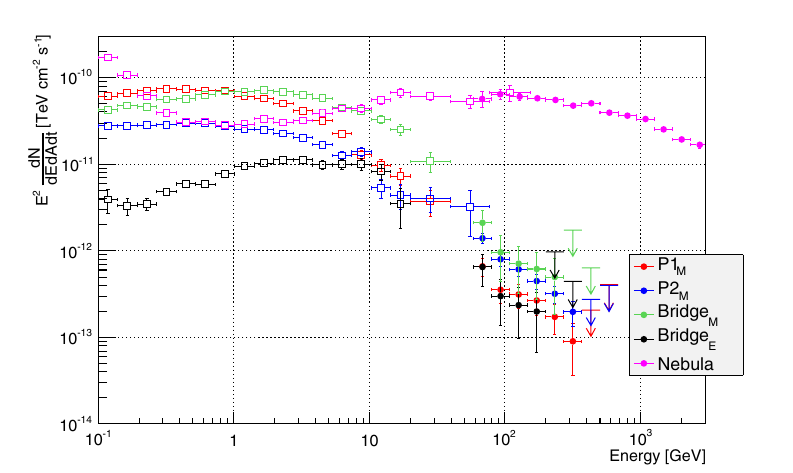
Figure 3. Spectral energy distributions of the Crab nebula, P1 M , P2 M , Bridge M , and Bridge E measured with Fermi -LAT (below 50 GeV) and MAGIC (above 50GeV). The flux values averaged over the rotation period are